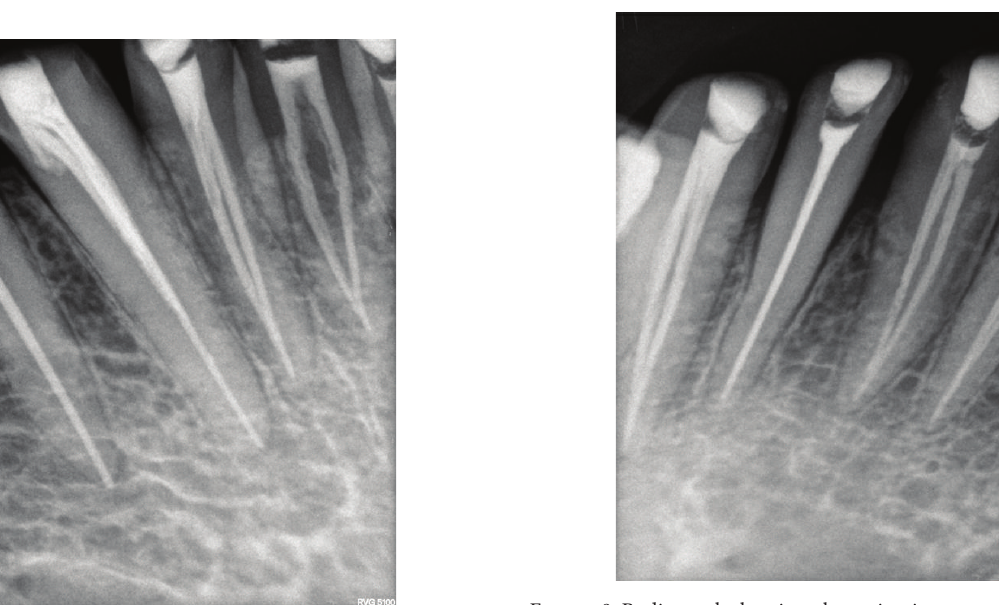
Figure 8: Radiograph showing obturation in two separate canals in 32 and